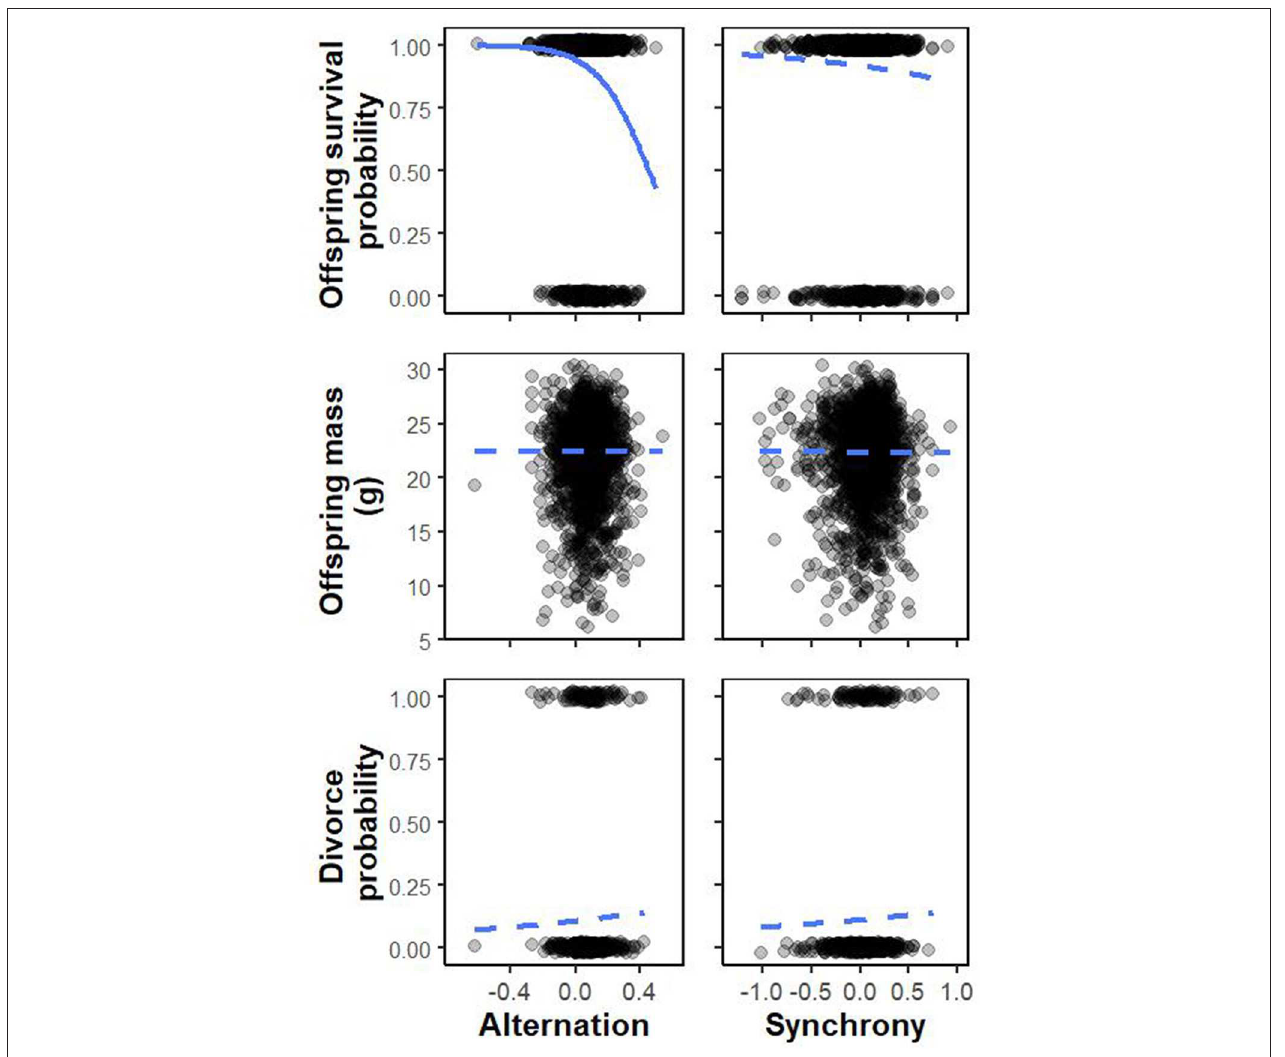
FIGURE 2 | Effect of the pairs’ deviation in alternation and synchrony averaged within brood observations and transformed on the log scale on: (top row) the probability of offspring surviving from age 5 days to ringing (middle row), offspring mass at 11 days old (bottom row), the pair’s probability of divorcing. Blue curves are dotted when the effects are not significant, and plain when the effect is significant. Note that the only significant effect is opposite expectation. Raw data (top row: offspring survived: 1, offspring did not survive to fledge: 0; bottom row: divorce: 1, did not divorce: 0) are also